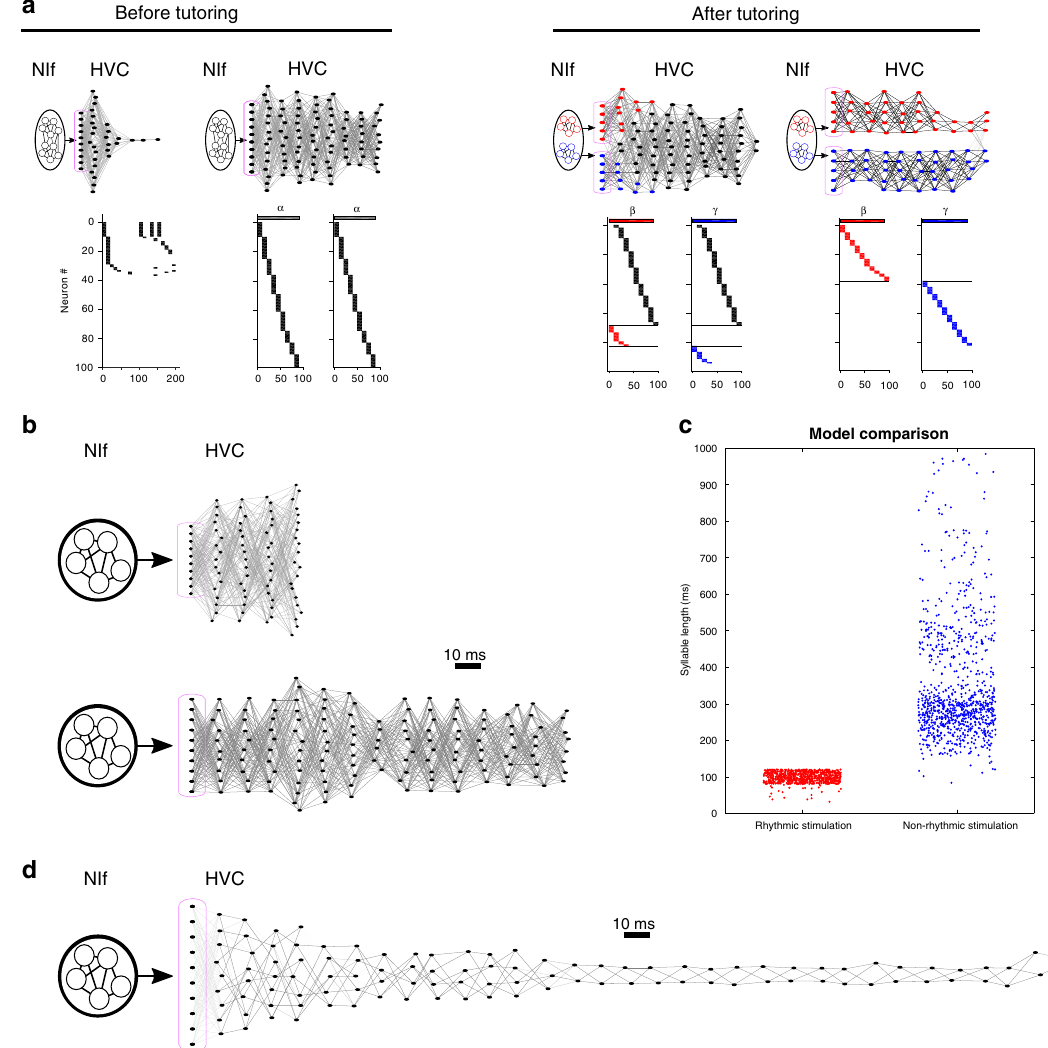
Fig. 8 Combined NIf/HVC model. a HVC model driven by NIf inputs into seed neurons in HVC, at four stages throughout learning (magenta boxes indicate seed neurons). Network diagrams of participating HVC neurons are shown at top (darker lines indicate stronger connections; and HVC neurons are sorted horizontally according to their latency relative to seed neurons). HVC network activity plots are shown below for example syllables. Left: before tutoring, NIf activity drives the formation of a single protosyllable chain in HVC. Right: after tutoring, clustered activity in NIf drives chain-splitting in HVC. b Rhythmic NIf input to seed neurons in HVC was driven at different periodicities: (top) 50 ms, and (bottom) 150 ms. Network diagrams show the HVC network after learning. c Length of syllables (duration of HVC activity) in the combined NIf/HVC model after the two stimulation protocols in Zhao et al. 62 : (red) Rhythmic NIf stimulation with period of 100 ms; (blue) non-rhythmic NIf stimulation. d An example HVC network diagram for a long chain (330 ms) produced by non-rhythmic NIf clustered in a narrow window 25 ms following syllable onset, the PSTH in this window was compared to control PSTHs in this window. Population analyses combined syllable-aligned PSTHs across neurons. First, the PSTH of each neuron was normalized (mean subtracted; divided by standard deviation). Then, an average PSTH was calculated across the population. In order to assess the signi fi cance of the peak in the population response, a control set of PSTHs was generated by shifting the PSTH of each individual neuron by a different random amount (uniform between − 100 and 100 ms) in time. Plots show shaded regions at the p = 0.01 level. Random controls are also used to assess the p -value of the peak population response. In several cases, the peak exceeded all 5× 10 6 random controls; here p -values are stated as p <2 ×10 − 6 . In order to analyze whether neurons were selective for particular syllable types, we performed ANOVA analyses comparing spike counts of the neuron across different syllable types. Spike counts were calculated in a window from 50 ms before syllable onset to 20 ms after syllable onset. Fig. 5. There are two types of input to the network: fi rst, a syllable-speci fi c auditory input that is only active during the tutoring context, and second, a syllable onset signal that is active during both tutoring and singing. The fi rst type of inputs were